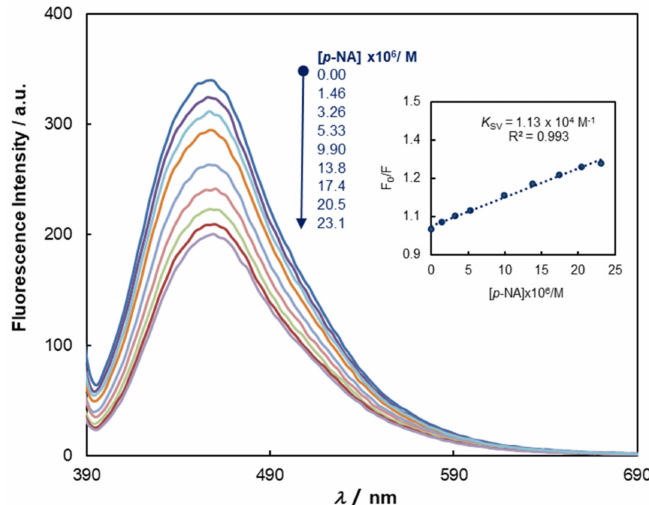
Figure 8. Emission spectra of aqueous dispersions of C-dots (0.01 mg/mL) after successive additions (from 4.47 × 10 − 7 M up to 2.31 × 10 − 5 M) of p -NA ( λ exc = 380 nm). Inset: Stern–Volmer plot after correction for h